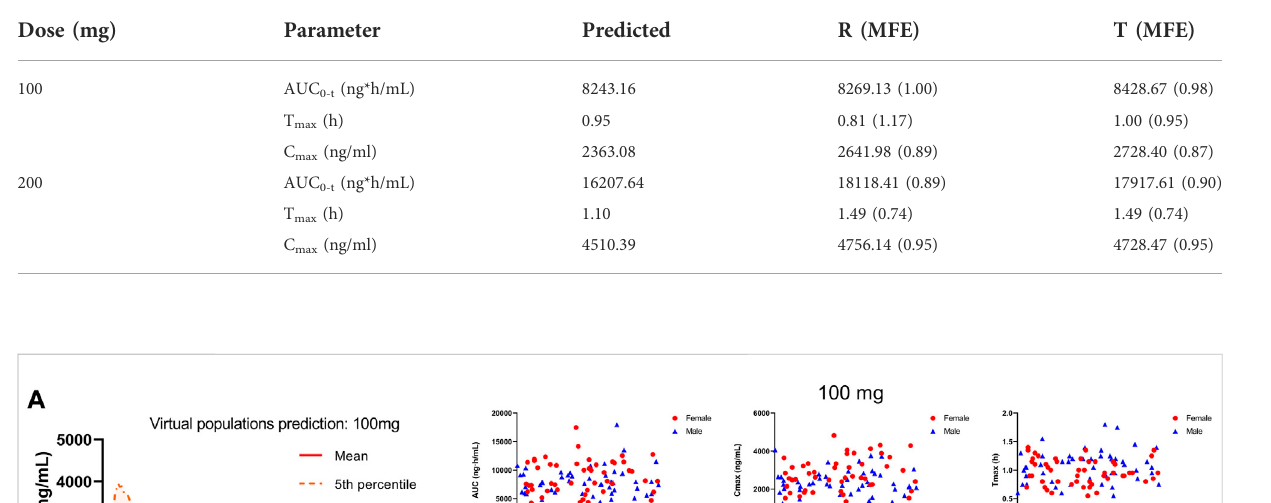
TABLE 5 Predicted and observed pharmacokinetic parameters of 100 and 200 mg PTU orally in the virtual adult population.